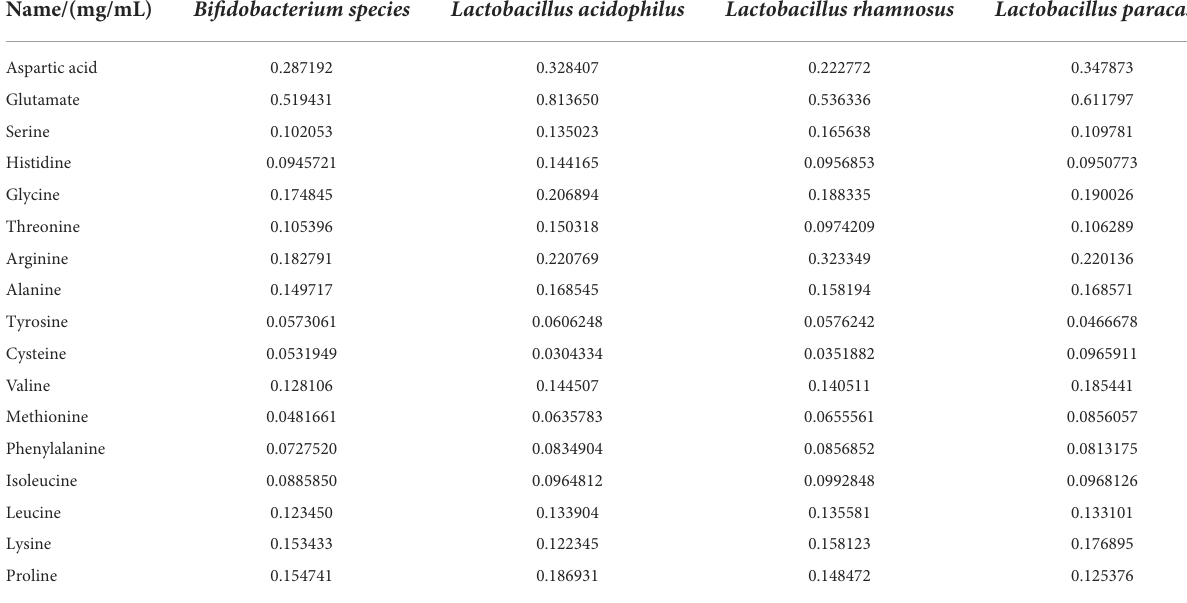
TABLE 2 Amino acid contents of fermentation peptides of four